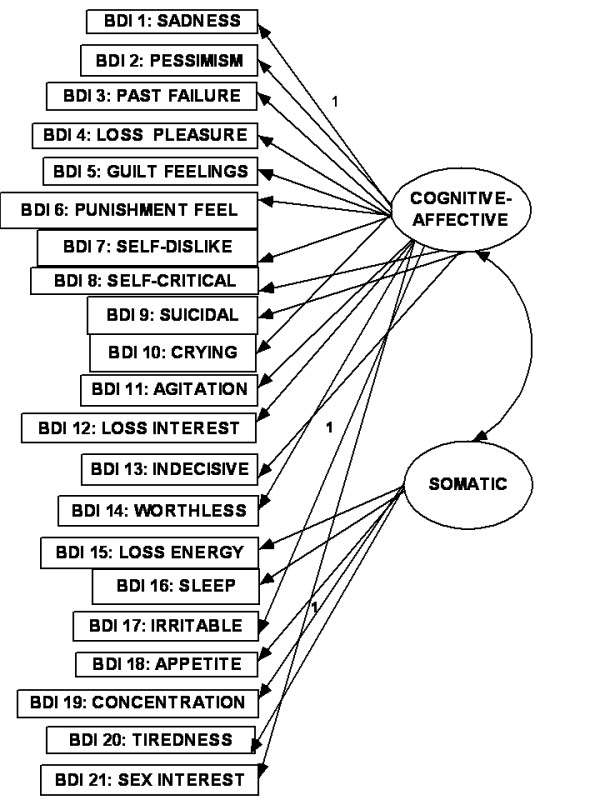
Cognitive-affective/somatic model.